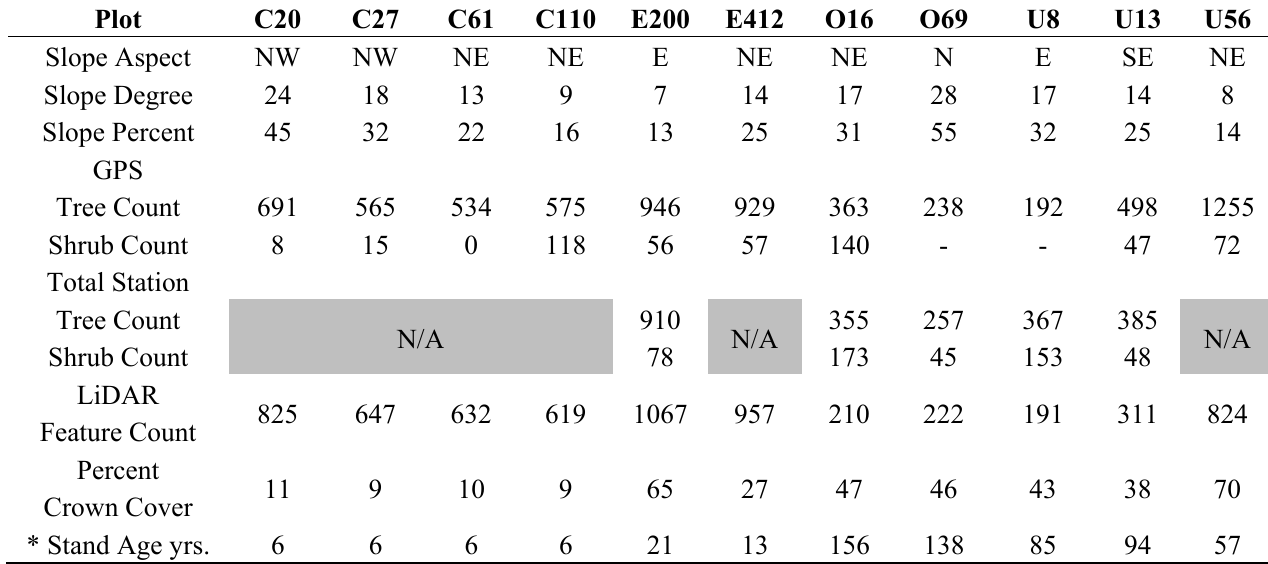
Table 1. Plot statistics for tree and shrub measurement comparison. Total station measurements collected on five plots and GPS measurements collected on all